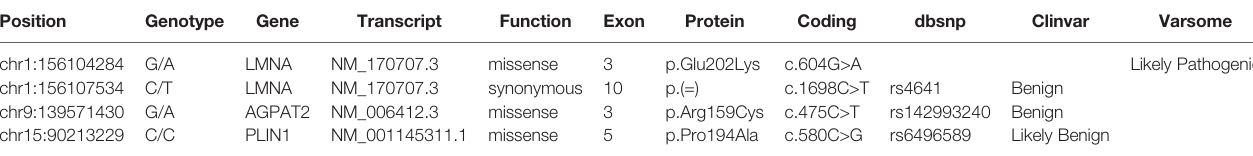
TABLE 2 | Genetic variants identi fi ed after NGS followed by adequate fi ltering.